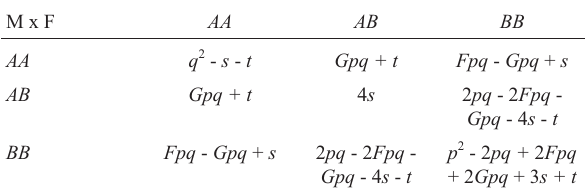
Table 1 - General mating